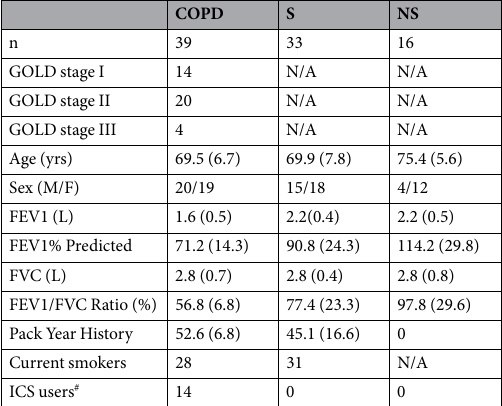
Table 1. Subjects’ Demographics. Data shown are mean (sd). FEV1: forced expiratory volume, FVC: forced vital capacity, ICS: inhaled corticosteroid. S: Smoking controls, NS: never smokers. # There were no patients on oral